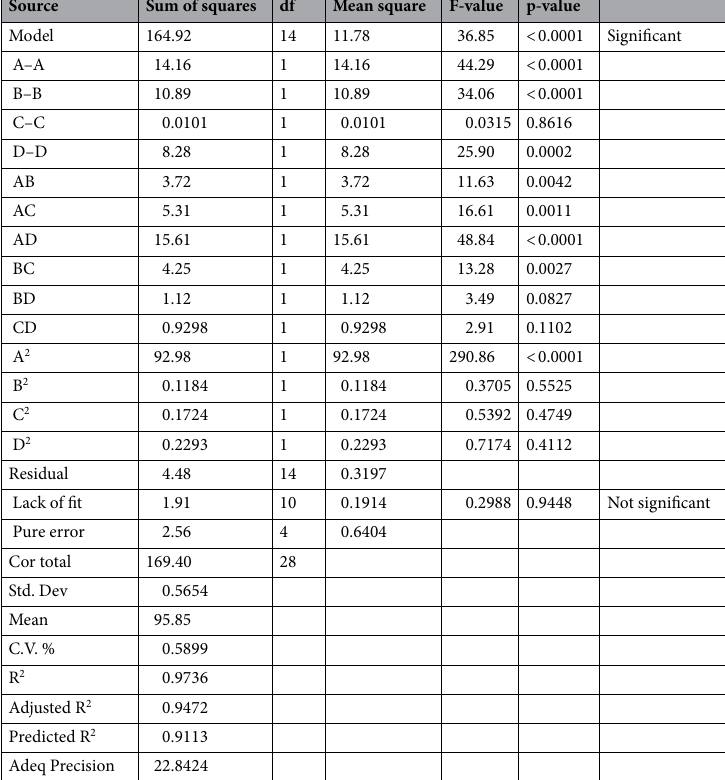
Table 4. Analysis of variance (ANOVA), results for decolourization of MgG by MgO impregnated